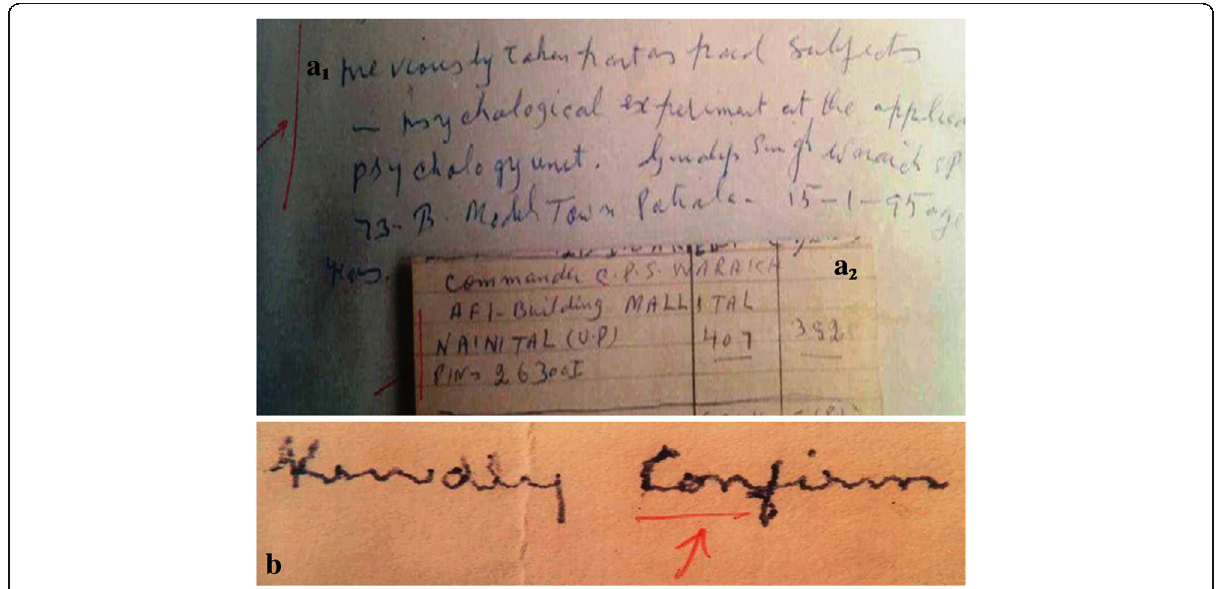
Fig. 5 Writing Speed. (a 1 ) Handwriting sample of an aged individual showing decline in writing speed as compared to the handwriting sample executed before the age of 60 years (a 2 ). (b) Handwriting sample of Parkinsonism patient showing very slow speed of